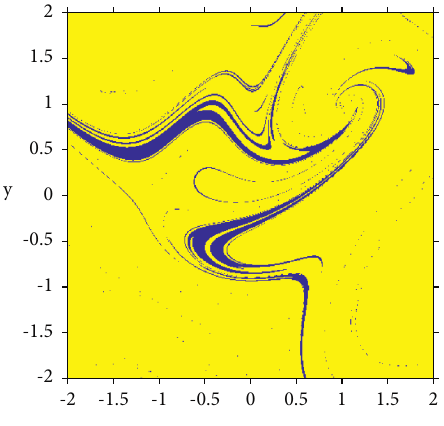
Figure 1: Chaotic attractor of system (3) when q � 1 according to the system parameters a � 1 and b � − 9 and the IC ( x (− 1 , 1 , 1 ) on (a) xy plane, (b) xz plane, and (c) yz plane.